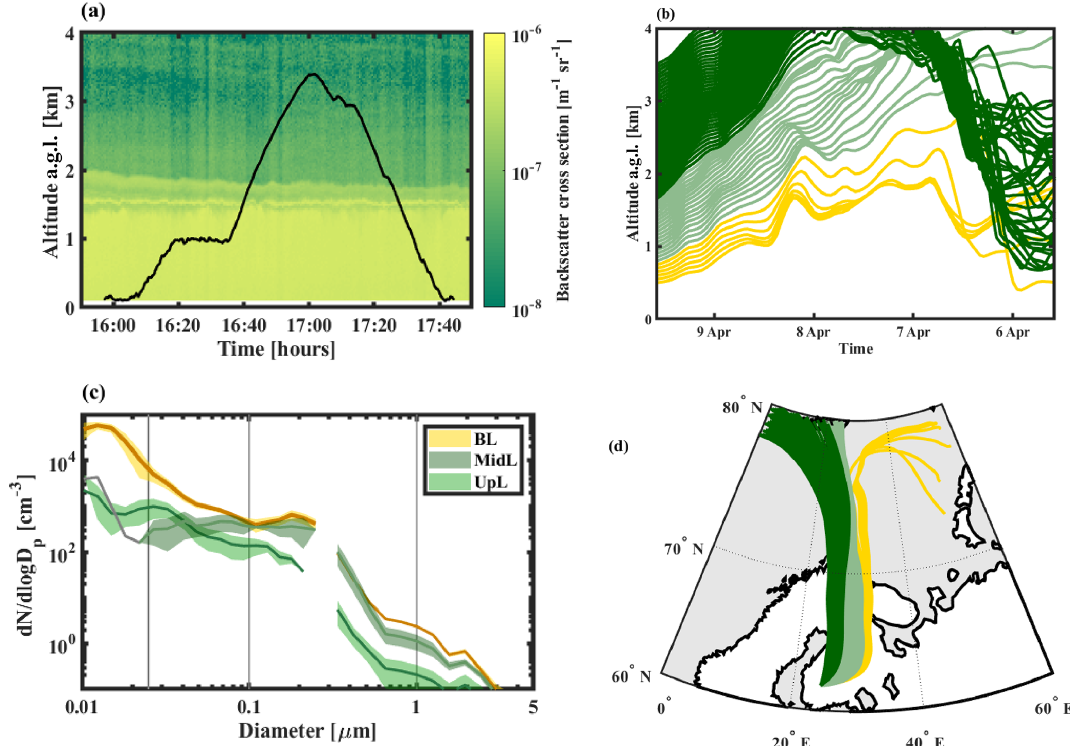
Figure 28. Clear-sky case study during 9 April 2014 at SMEAR II, Finland: (a) HSRL backscatter coefficient with Cessna flight altitudes in black; (b) 96h backward trajectories calculated every 50m and combined into layers according to similarities in the traveling path; (c) aerosol size distribution measured onboard during the flight and combined into layers, shown with 1 standard deviation; (d) spatial coverage of backward